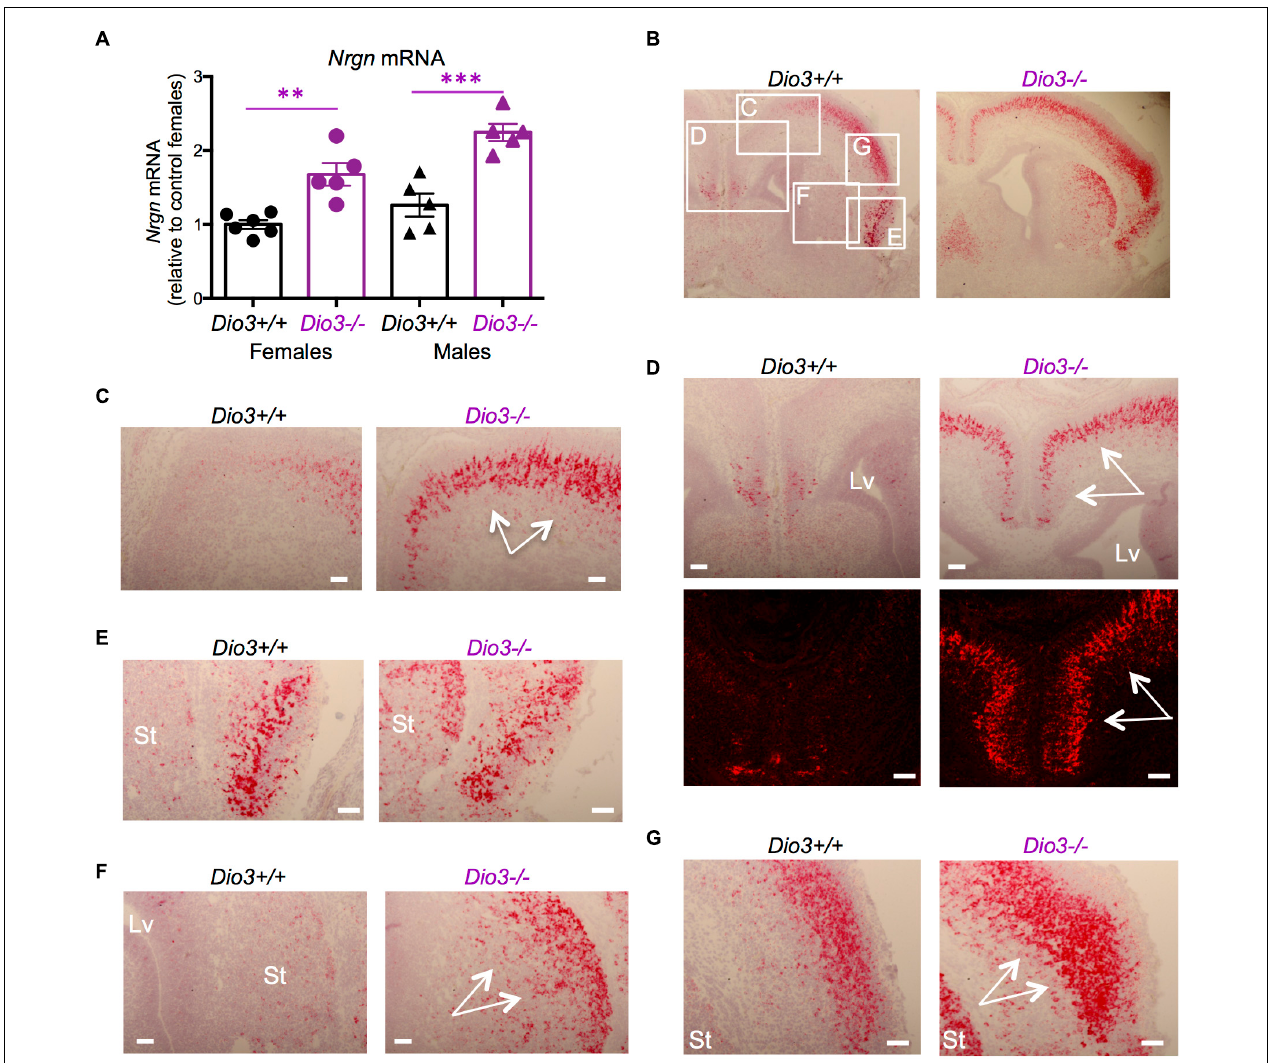
FIGURE 3 | Nrgn expression is elevated in E18.5 Dio3 − / − brains. (A) Nrgn mRNA expression in whole E18.5 brains. Data represent the mean ± SEM of 11 and 10 different samples from E18.5 Dio3+/+ and Dio3 − / − mice, respectively, divided by sex. ∗∗ and ∗∗∗ p < 0.01 and p < 0.001, respectively, E13.5 vs E18.5 as determined by the ANOVA and Tukey’s post hoc test. (B–G) , Bright field and fluorescent images of in situ hydridization of Nrgn mRNA in whole brain coronal sections (B) , motor cortex (C,D) , frontal/cingular cortex (D) , piriform cortex (E) , striatum (F) and second somatosensory cortex (G) . Images are representative of two different animals of each genotype. Rectangles and letters indicate the panels in which those anatomic regions are amplified. St, striatum; Lv, lateral ventricle. Arrows indicate areas of major differential expression. Scale bars are 40